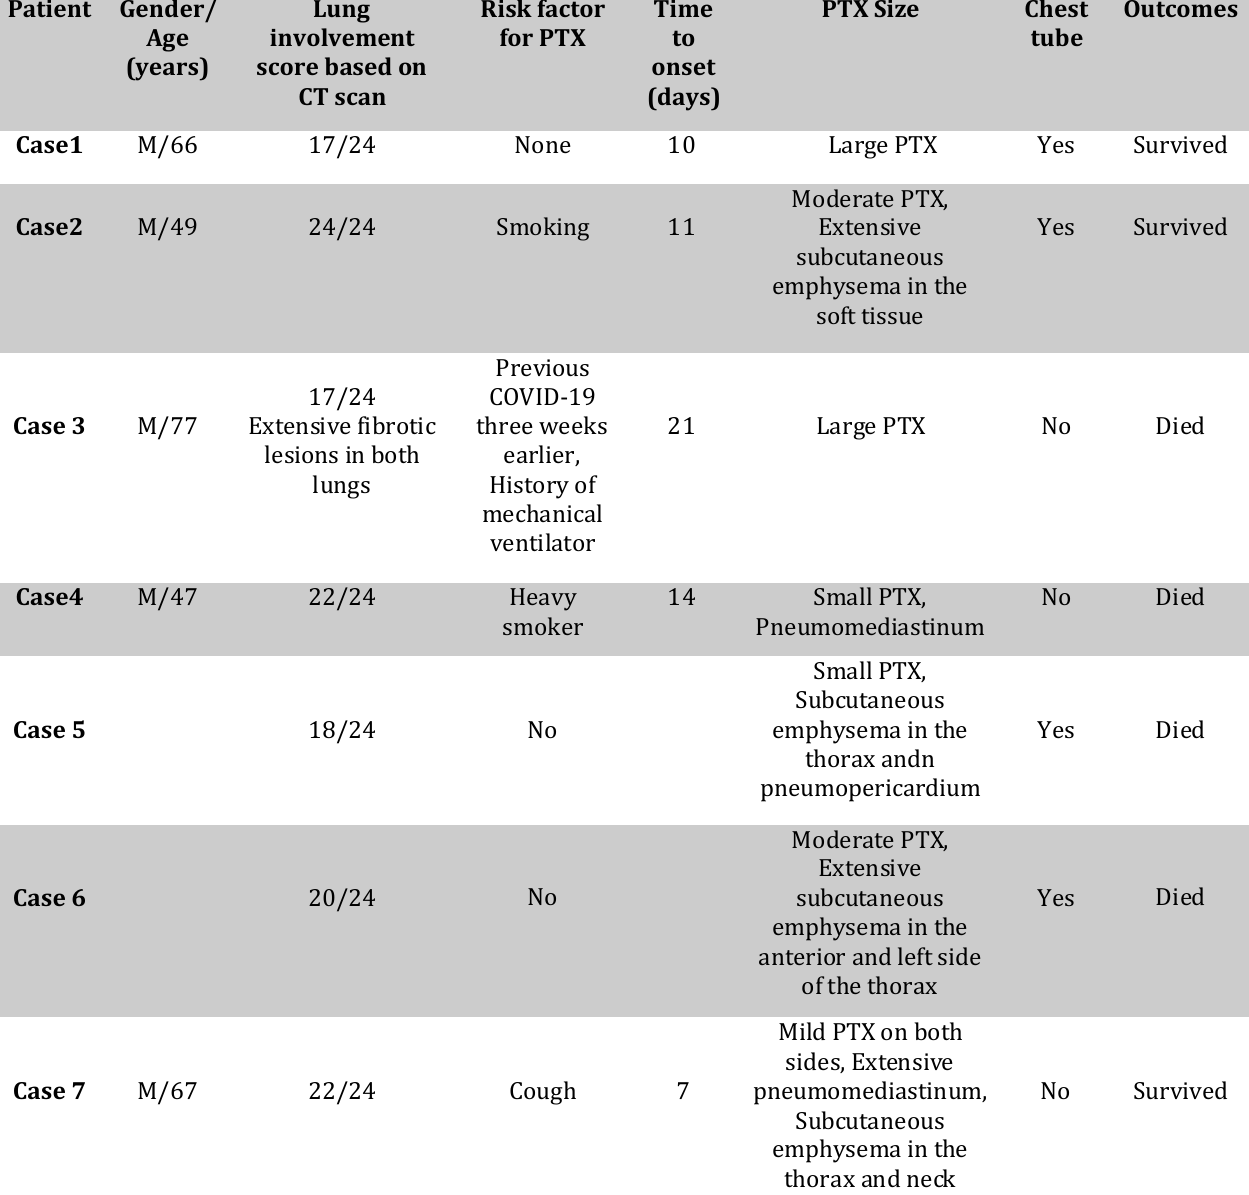
PTX: Pneumothorax, pulmonary involvement scores based on the amount of patchy ground glass and consolidation opacities (max score: